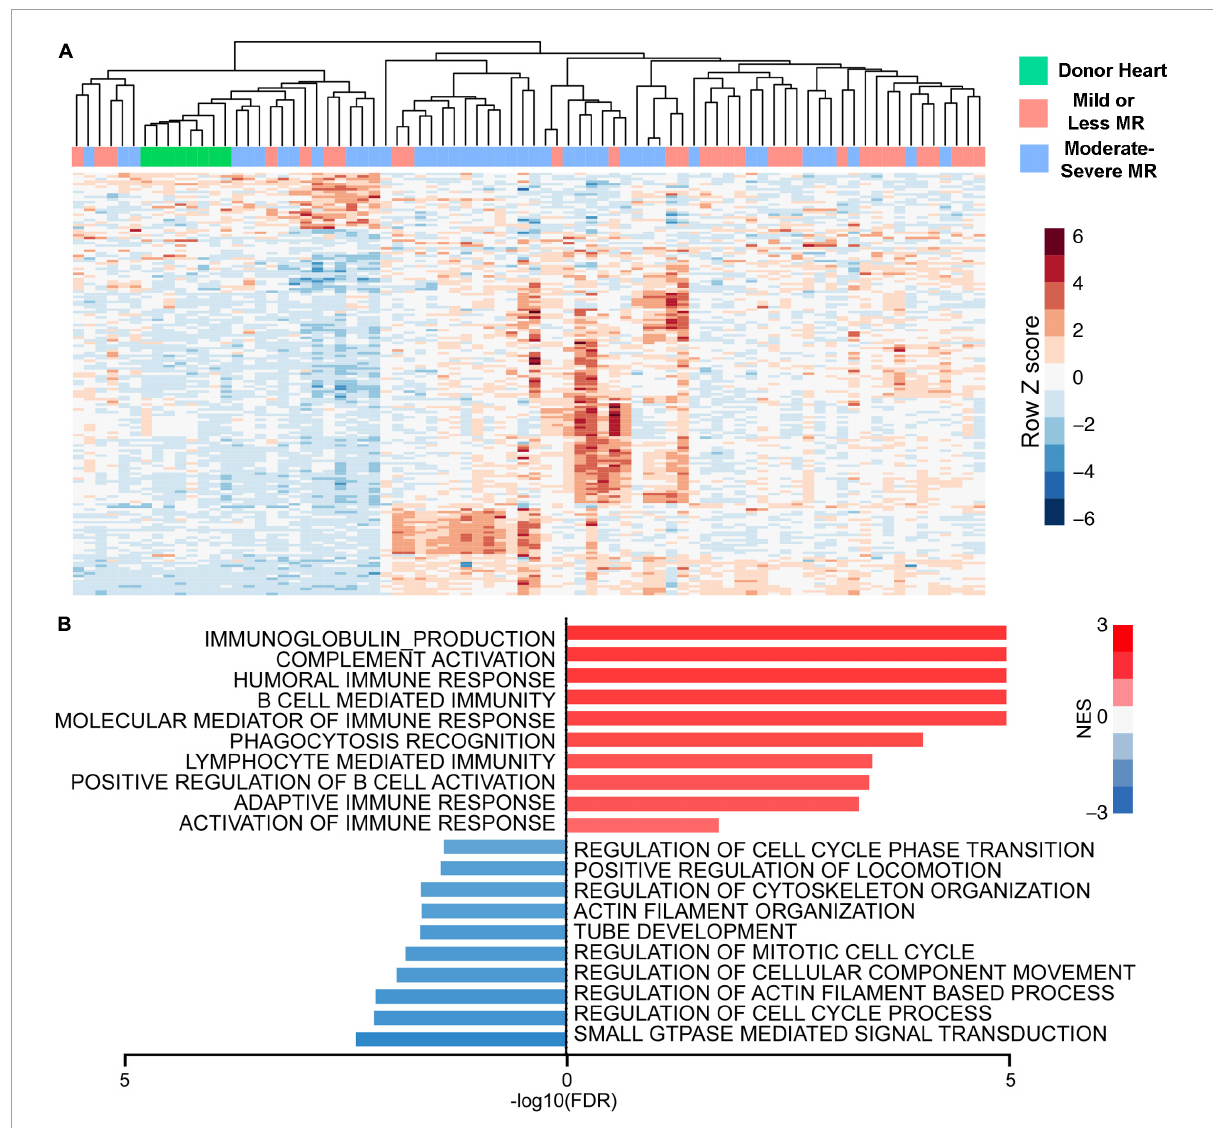
FIGURE3 Greater mitral regurgitation (MR) severity is associated with heightened expression of immune response genes and down-regulation of genes associated with cellular proliferation and structure. (A) Heatmap of subtype specific differentially expressed genes (DEGs). (B) Gene set enrichment analysis using moderate-severe MR-specific regulated